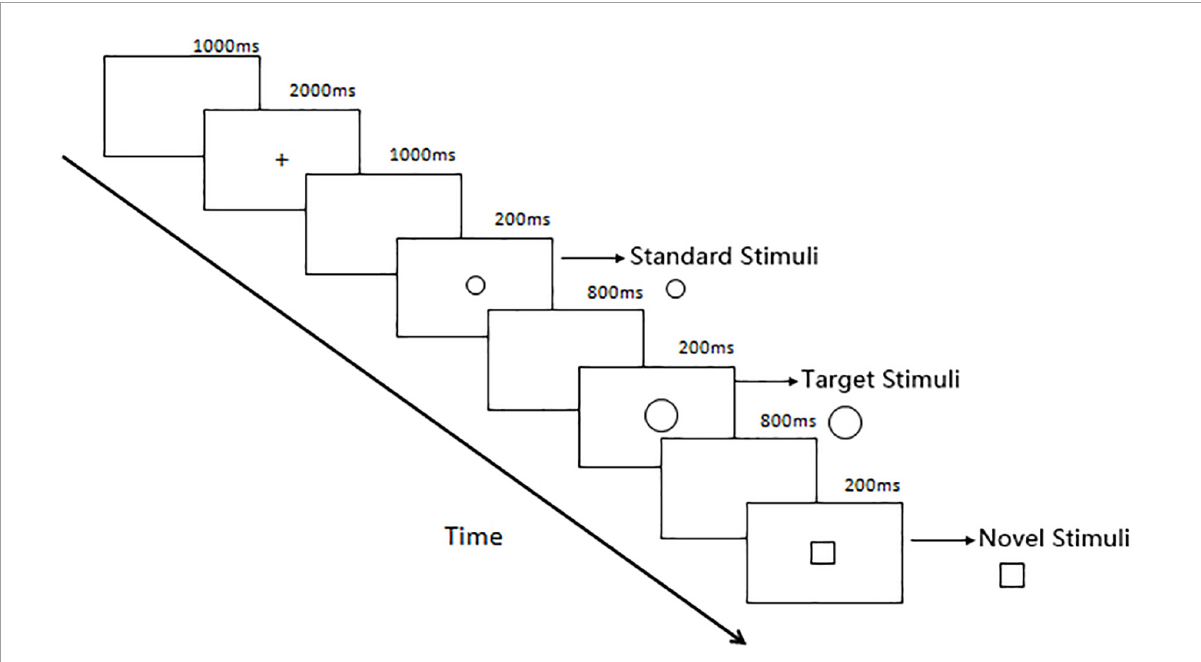
FIGURE1 Flow chart of the oddball